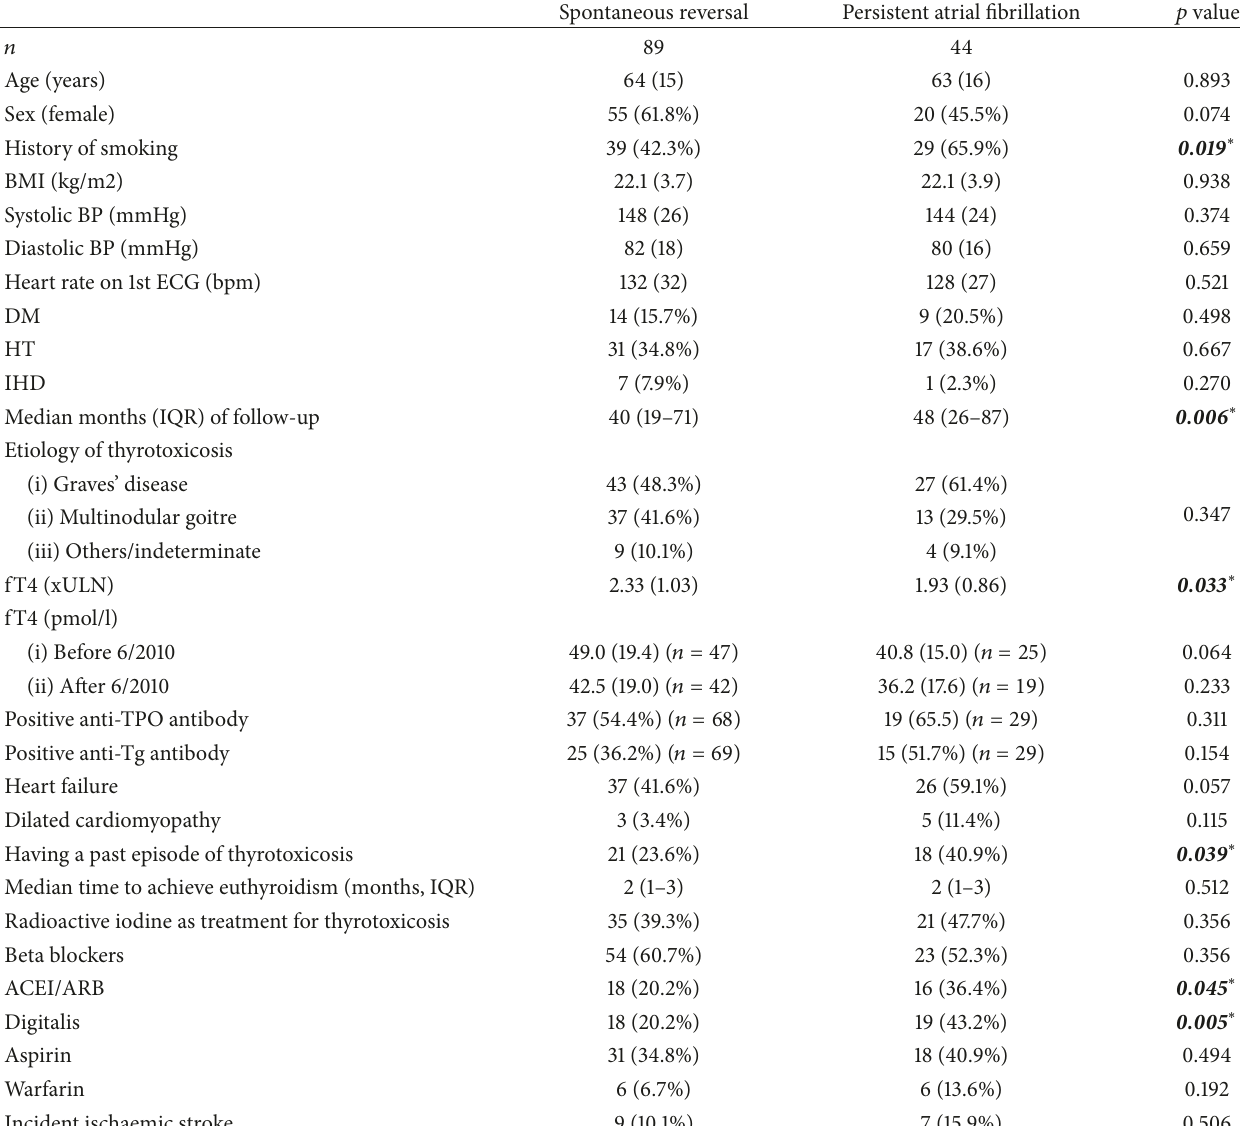
Table 1: Comparison of clinical characteristics of patients with spontaneous reversal of atrial fibrillation to sinus rhythm versus patients with persistent atrial